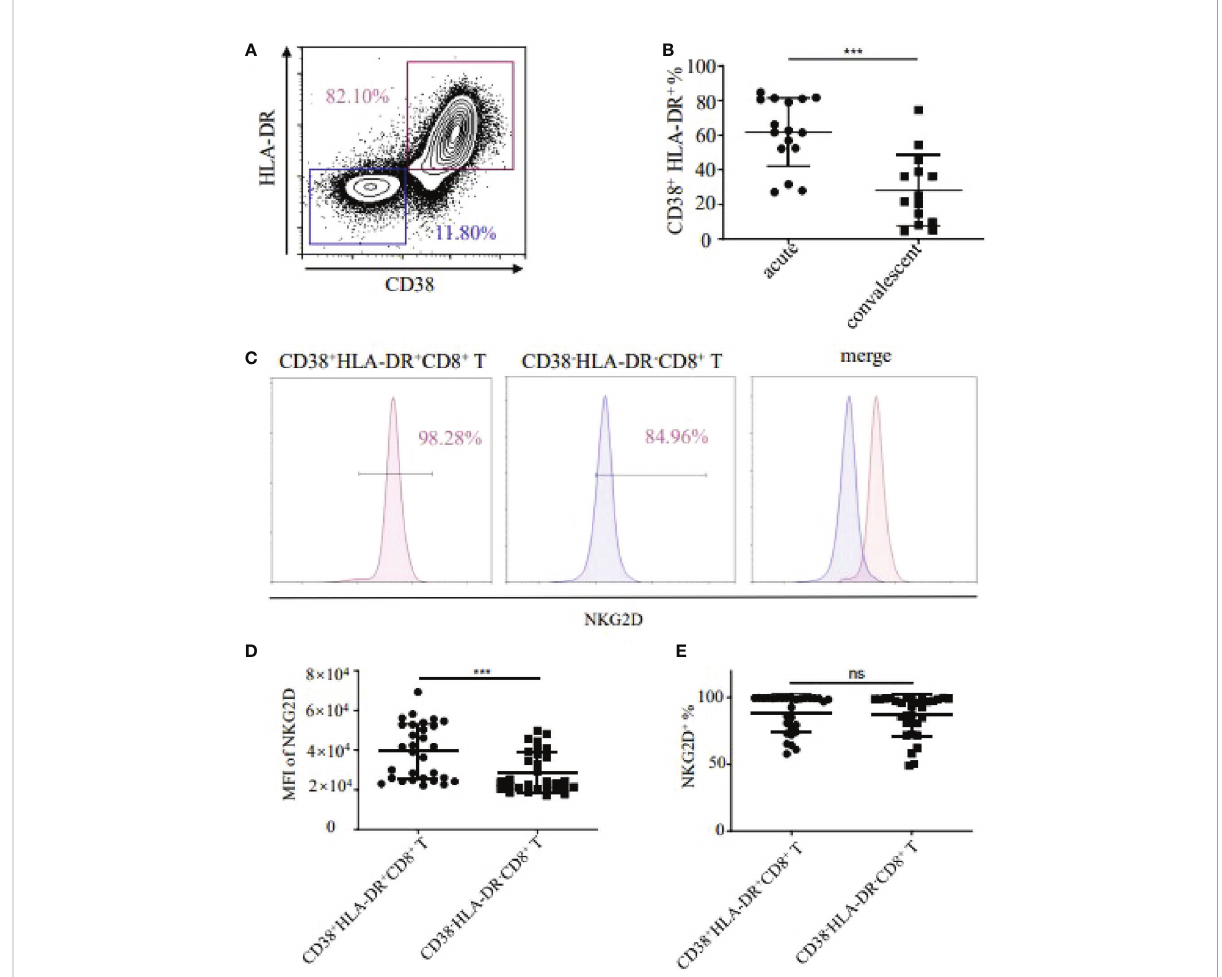
FIGURE 1 Detection of CD38 + HLA-DR + CD8 + T cells and expression of NKG2D in HFRS patients. (A) Representative fl ow cytometry of CD38 and HLA-DR expression in CD8 + T cells. (B) Comparison of the frequencies of CD38 + HLA-DR + in CD8 + T cells between acute (n=16) and convalescent phase (n=14) in HFRS patients. (C) Representative fl ow cytometry of NKG2D expression in CD38 + HLA-DR + or CD38 - HLA-DR - CD8 + T cells. (D, E) Comparison of the MFI (D) or the frequencies (E) of NKG2D between the CD38 + HLA-DR + CD8 + T cells (n=30) and the CD38 - HLA-DR - CD8 + T cells (n=30). The signi fi cance of the differences between two groups was determined by the Mann – Whitney U -test. p-Values<0.05 were considered to be statistically signi fi cant. ***p<0.001; “ ns ” means no signi fi